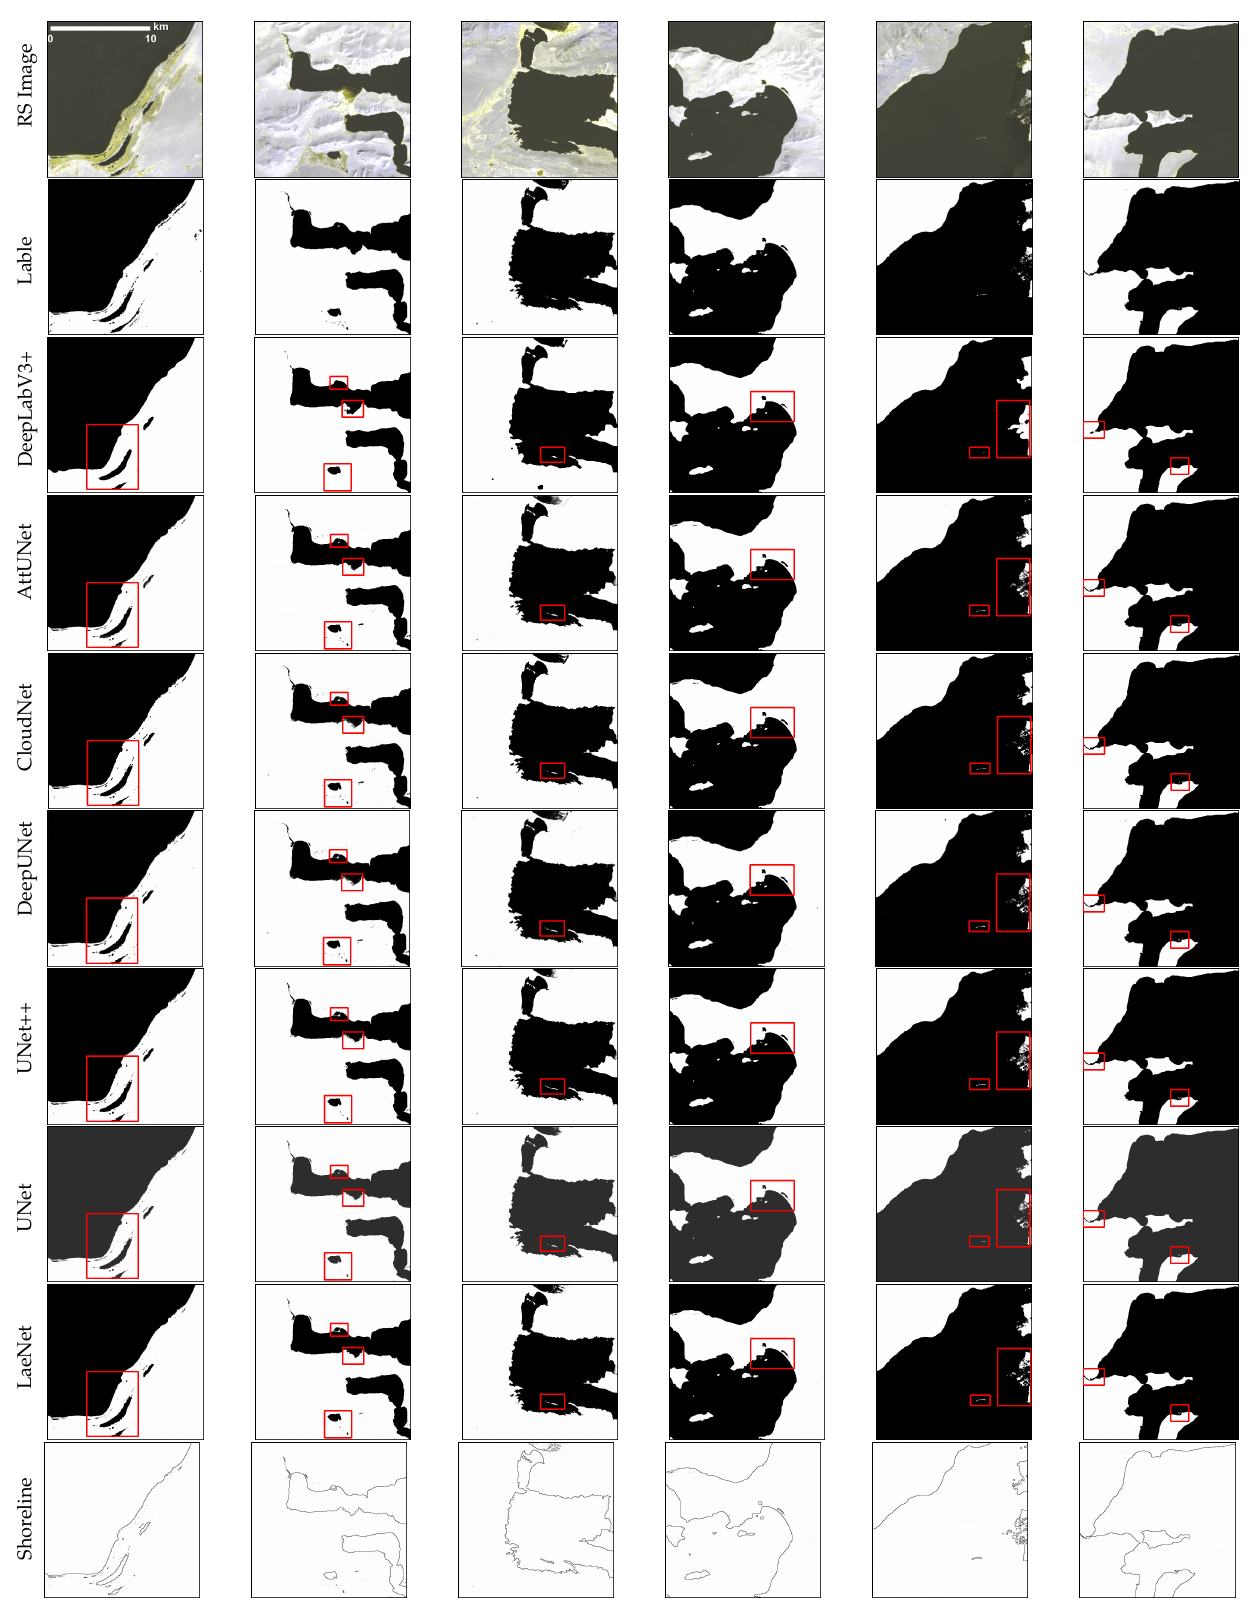
Figure 6. Lake segmentation visualization from DeepLabV3+ [54], AttUNet [63], CloudNet [64], DeepUNet [65], UNet++ [66,67], UNet [51] and lake segmentation and shoreline results from our proposed LaeNet